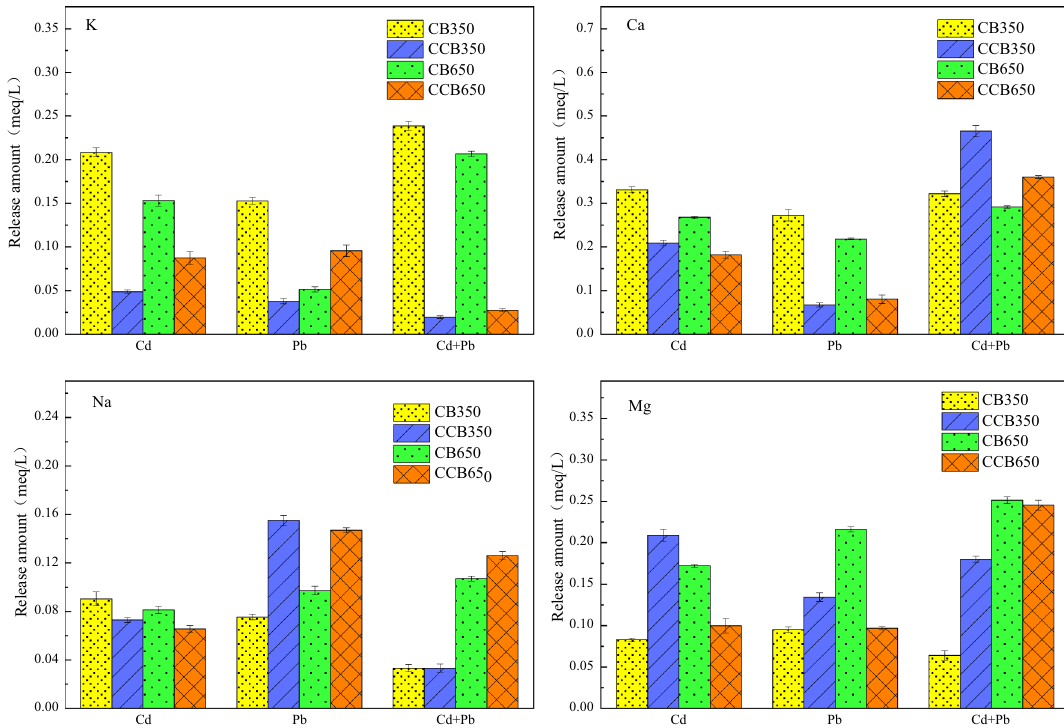
Figure 4. Net release amounts of K + , Ca 2+ , Na + , and Mg 2+ from biochars before and after